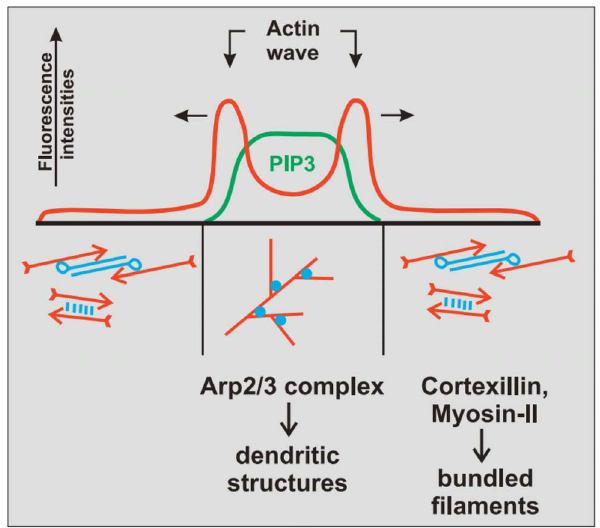
Figure 2. The spatial localization of components in an actin wave network, modified from [ 22 ] . The diagram represents F-actin and PIP 3 densities along a TIRF line scan through a closed actin wave in a cell attached on a glass surface. The wave fronts are propagating outwards while PIP 3 localization coincides with the dendritic network comprising the actin wave.